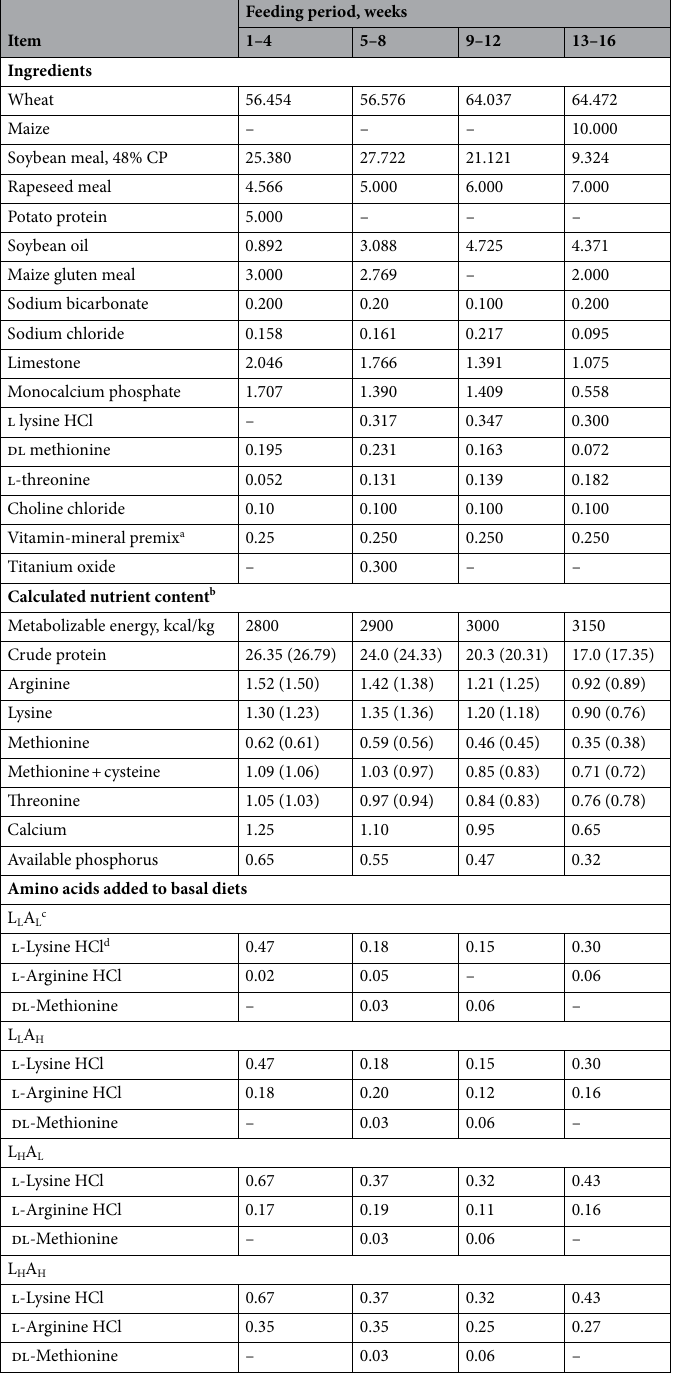
Table 8. Ingredient composition and nutrient content of basal diets (g/100 g, as-fed basis) fed to turkeys. a Provided per kg diet (feeding periods: weeks 0–4, 5–8, 9–12 and 13–16): mg: retinol 3.78, 3.38, 2.88,